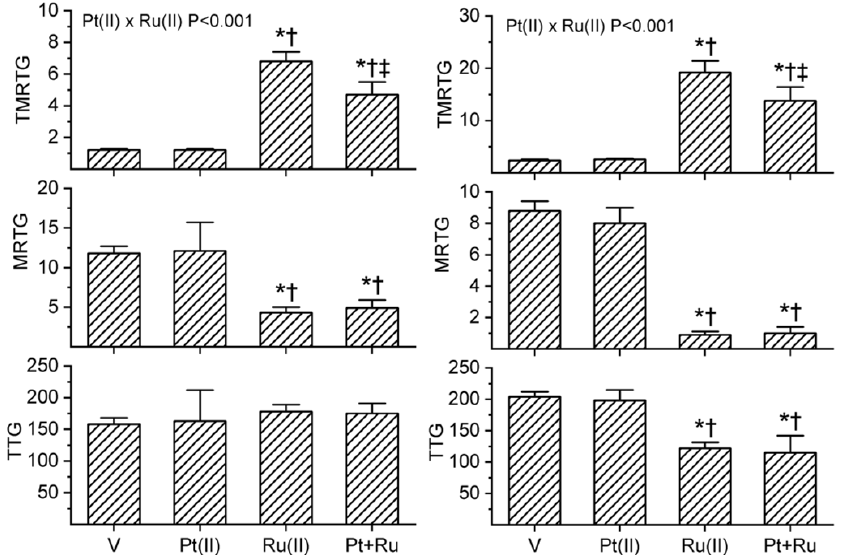
Figure 6. Procoagulant activity of B. moojeni venom (left panels) and C. rhodostoma venom (right panels) in plasma after exposure to carboplatin (Pt(II)), CORM-2 (Ru(II)), or both (Pt + Ru) in isolation. Data is presented as mean ± SD. V = venom; Pt(II) = V + carboplatin in PBS; Ru(II) = V + CORM-2; Pt + Ru = V + carboplatin and CORM-2. * p < 0.05 vs. V; † p < 0.05 vs. Pt(II); ‡ p < 0.05 vs. Ru(II) via one-way analysis of variance (ANOVA) with Holm–Sidak post hoc test. Significant interac- tions between carboplatin and CORM-2 (Pt(II) × Ru(II)) determined with two-way ANOVA are displayed within individ- ual parameter